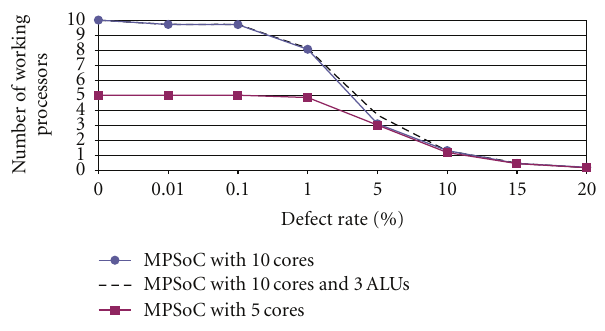
Figure 17: Performance degradation of the MPSoC—considering an application with 70% of available parallelism. Both MPSoC solutions,without fault tolerance approach and with two processors per core, present sequential execution under 10% defect rate and completely fail under a 20% defect